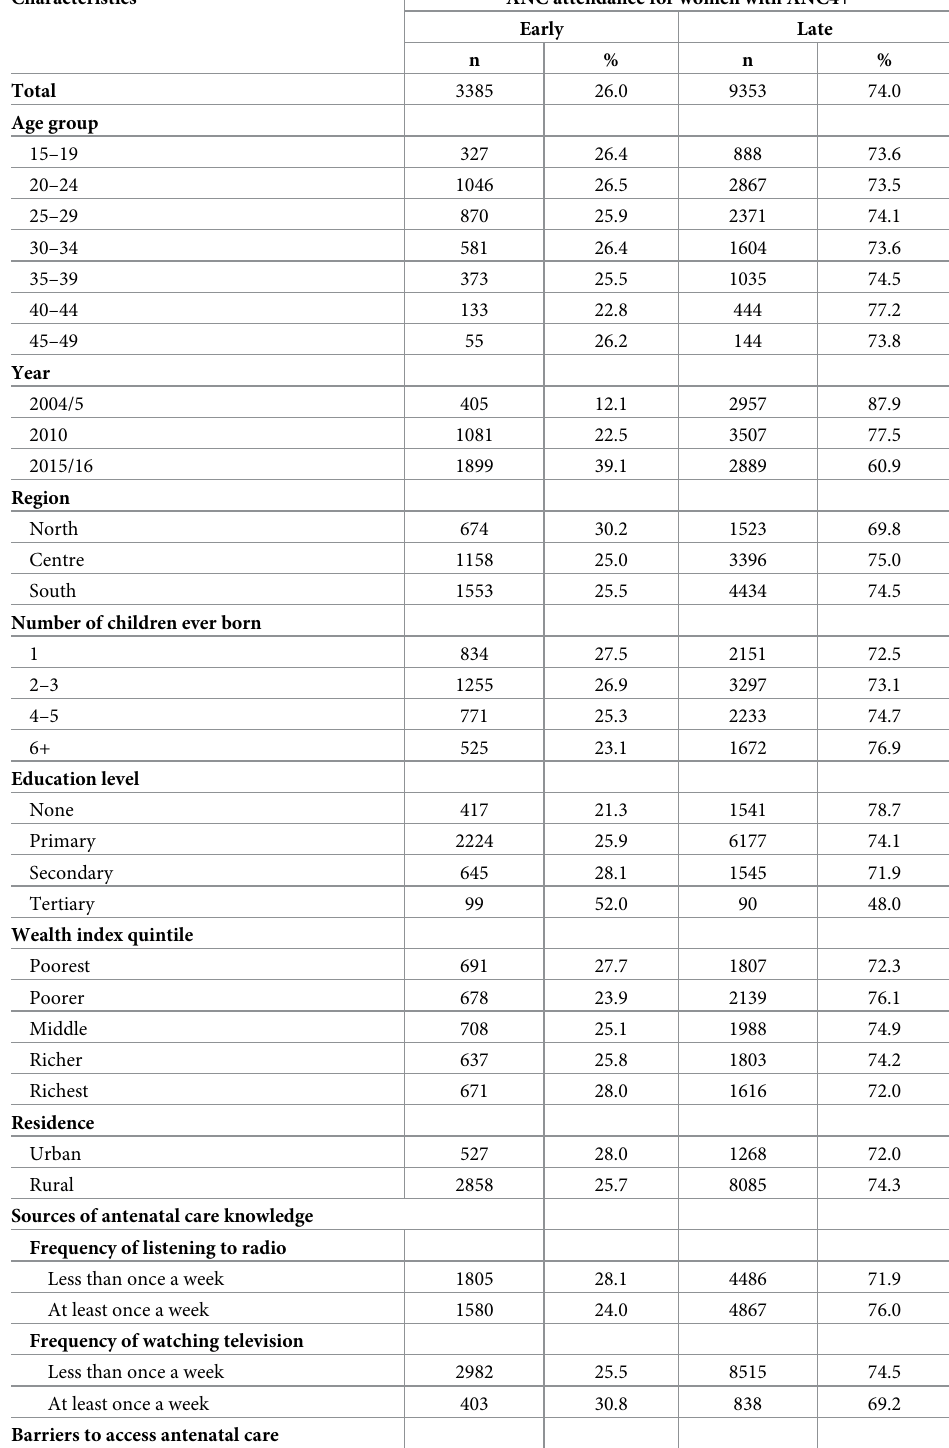
Table 4. Distribution of women with at least four antenatal care visits by the socio-demographic characteristics of the women in Malawi between 2004 and 2016.